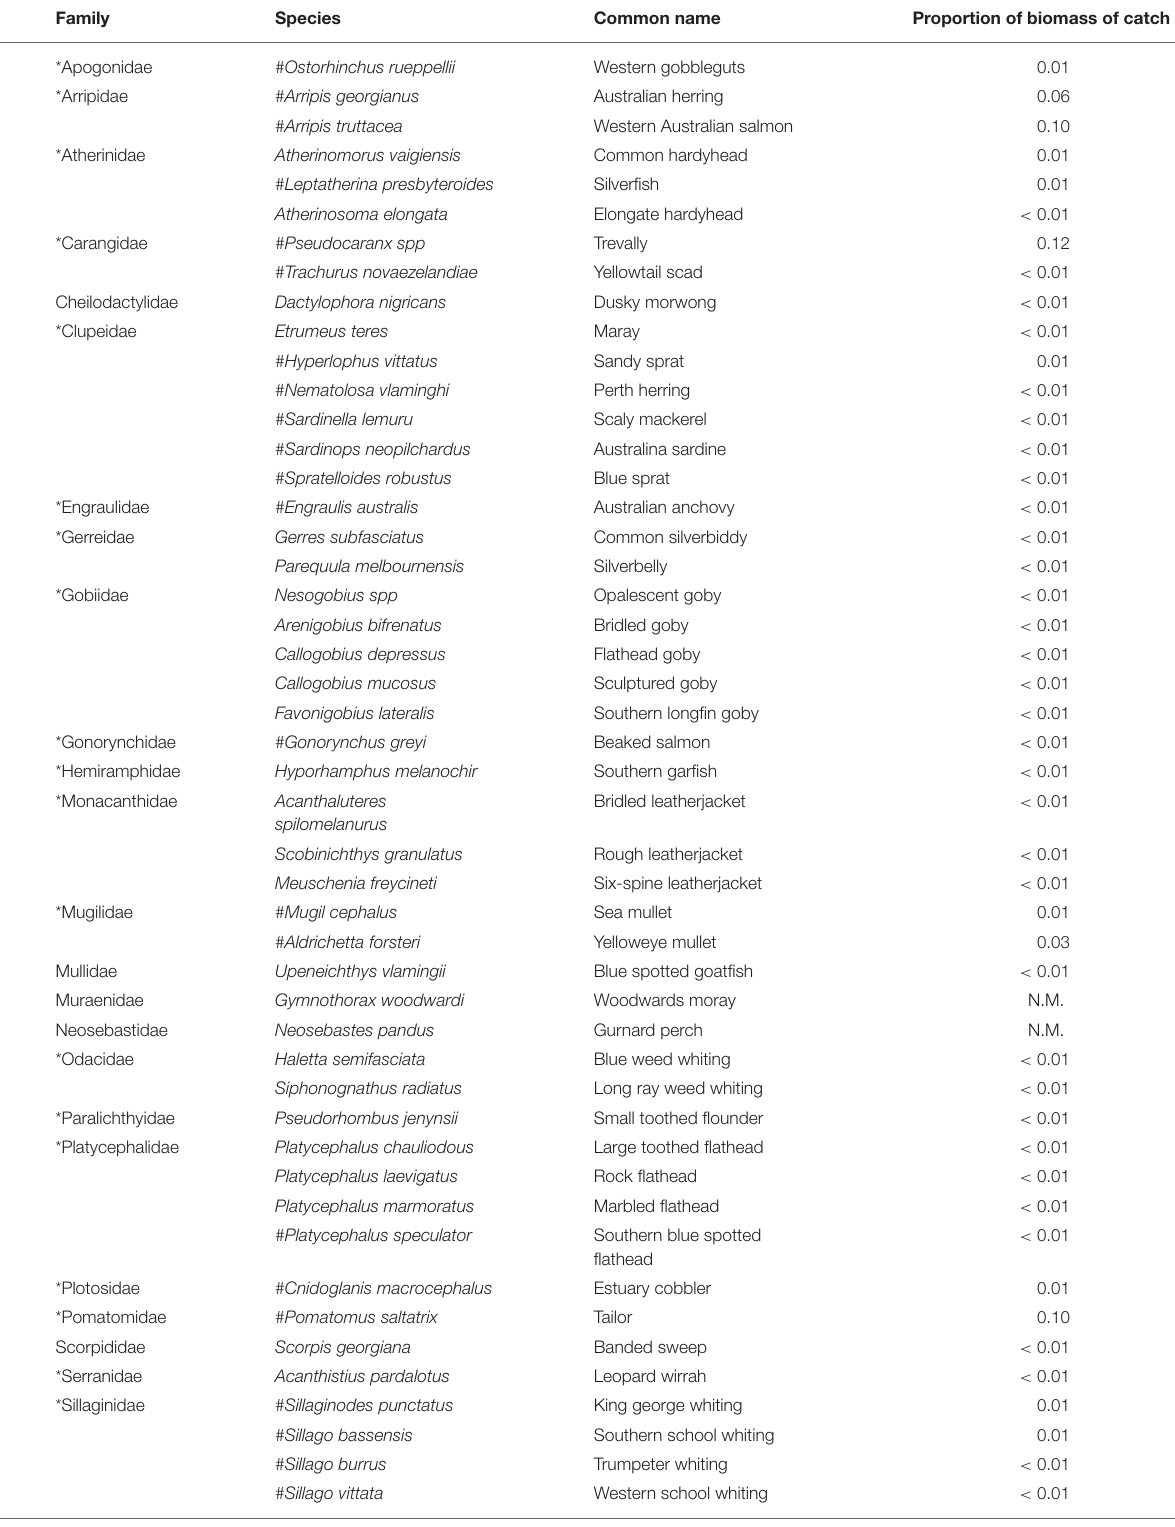
TABLE 2 | The proportional contribution to the total catch by biomass of each species caught by all sampling methods (z-traps, gillnet, and seine) in the Bunbury region between January 2008 and September 2010.